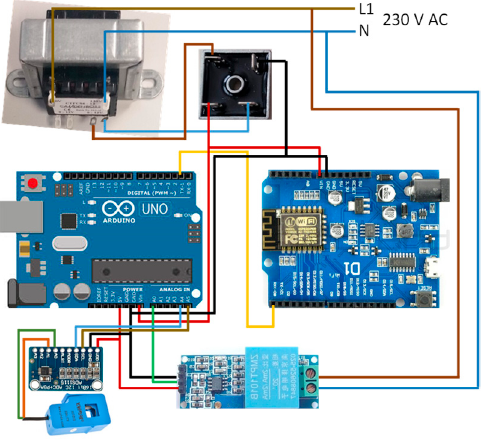
Figure 3. Wiring diagram of the OSPPSM.